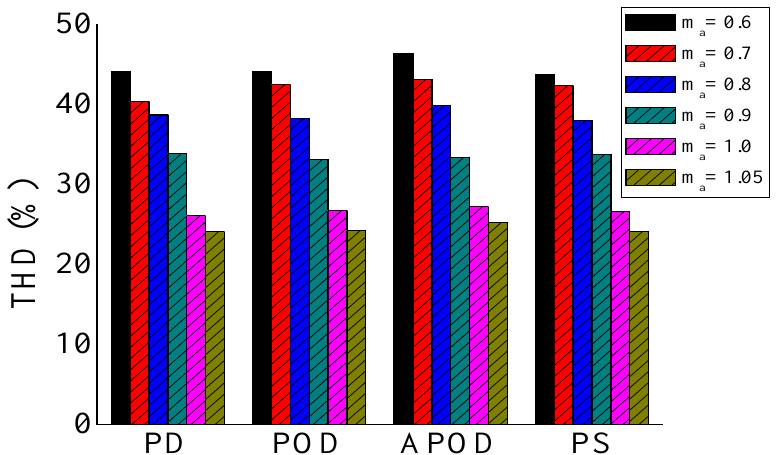
Figure 4. THD of the output voltage for varied m a at different switching approaches.